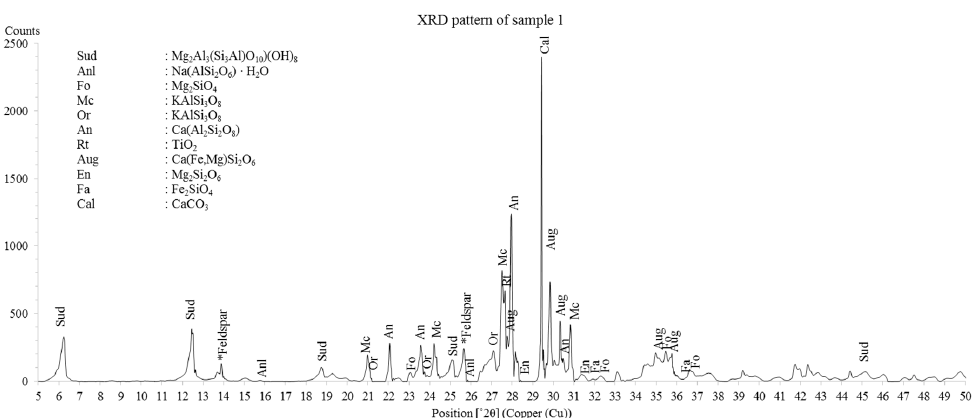
8 of 15 Figure 3. Petrography of Segamat basalt samples under PPL ( a , c , e , g ) and XPL ( b , d , f , h ) using 4× magnification. Cal, Fsp, Ol, Chl, Aug, and Opx represent calcite, feldspar, olivine, chlorite, augite, and orthopyroxene, respectively. Figures 4–7 present the mineralogical identification of Segamat basalt samples using XRD spectrum peaks. In accordance with previously reported data [24], the main crystalline phase of Segamat basalt is an olivine group including fayalite (Fe 2 SiO 4 ) at the 2 θ position of 31.6° and 35.9°, and forsterite (Mg 2 SiO 4 ) at the 2 θ position of 32.0°, 35.4° and 36.4°. Other crystalline phases are the pyroxene, chlorite, alkali feldspar, plagioclase, and zeolite group. The pyroxene group includes enstatite (Mg 2 Si 2 O 6 ) and augite ((Ca,Na)(Mg,Fe,Al,Ti)(Si,Al) 2 O 6 ), which mainly occur at the 2 θ position of 28.3° and 35.6°, respectively. From the chlorite group, sudoite (Mg 2 Al 3 (Si 3 Al)O 10 )(OH) 8 ) appears at the 2 θ position of 6.2°, 19.6°, 12.4°, 25.2°, and 44.8°. The peaks of 20.9°, 24.1°, 27.4°, and 30.7° refer to microcline (KAlSi